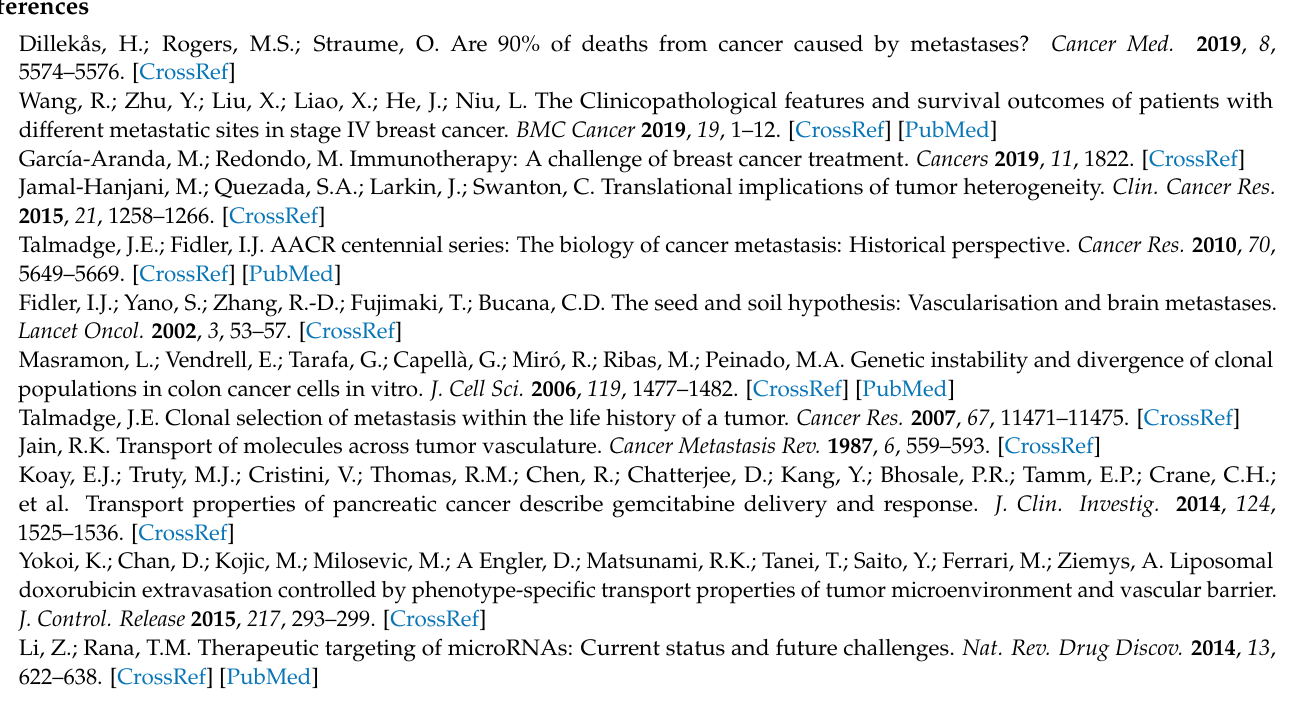
Figure S2. Limited distribution of iv injected fluorescently labeled anti-PD-L1 IgG into liver metasta- sis, Figure S3. Verification of immune maker that express PD-L1 by immunohistochemical imaging of primary tumor and liver metastases, Figure S4. Verification of endothelial cells (CD31) that